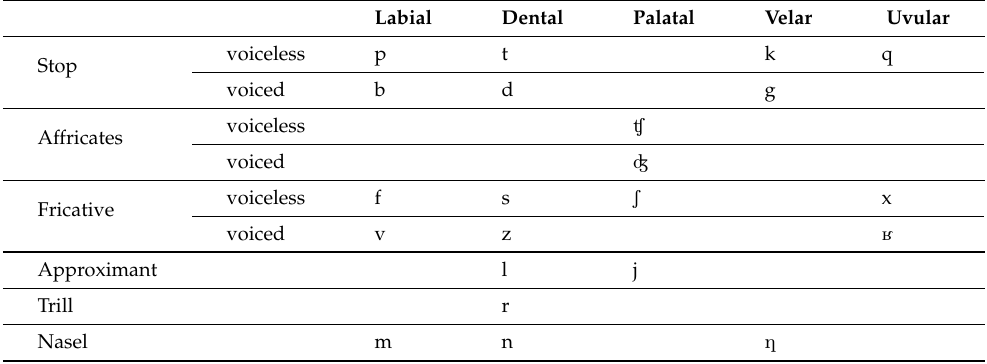
Table 3. The consonants of